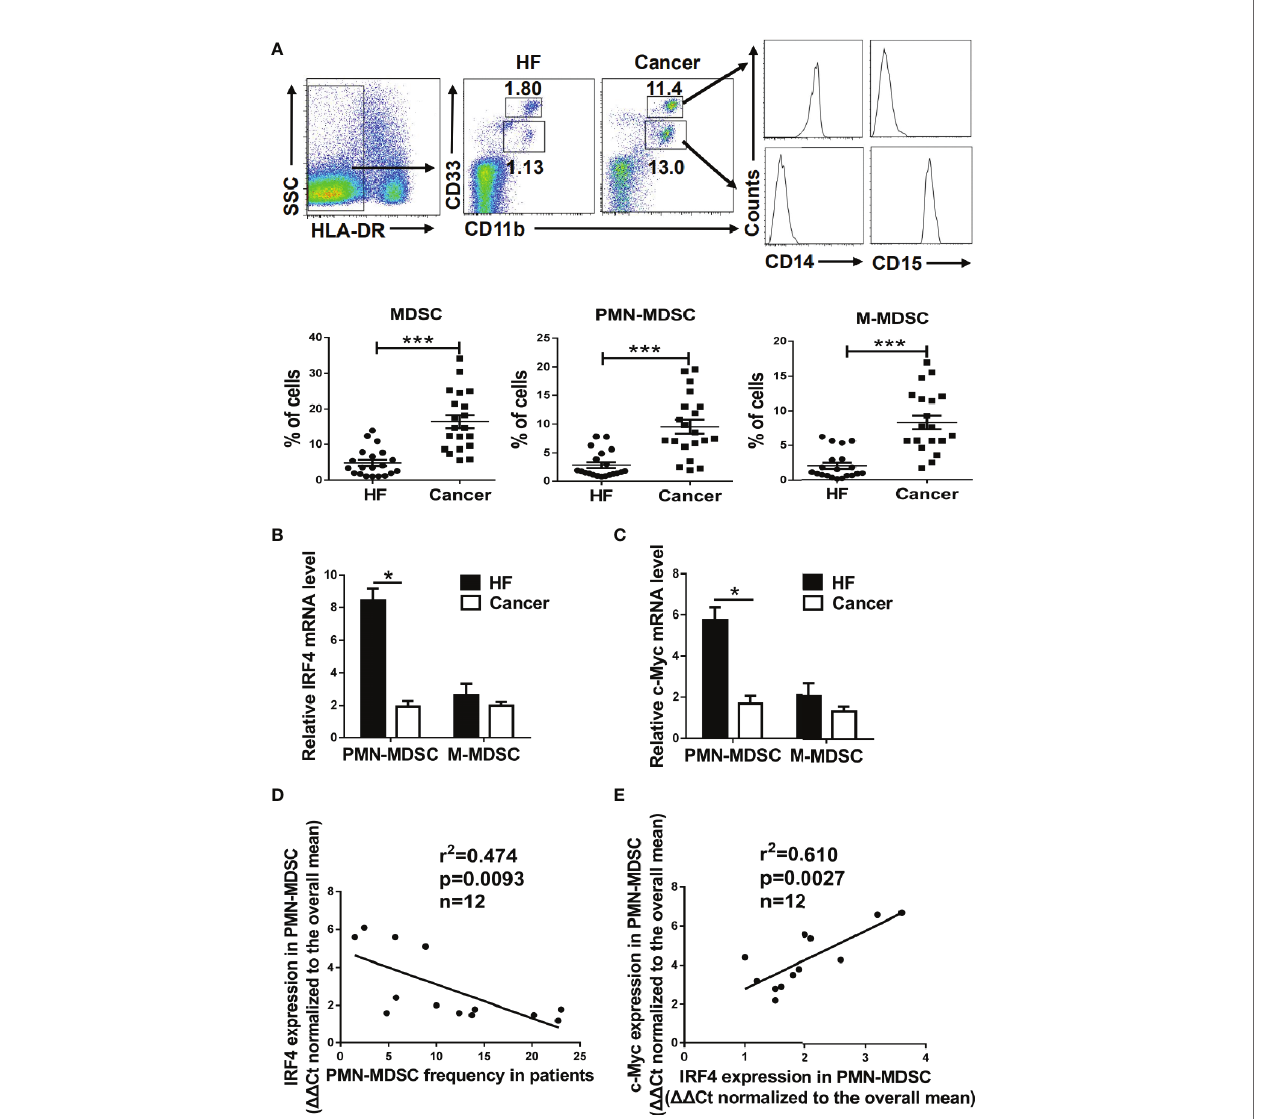
FIGURE 7 | Clinical signi fi cance of interferon regulatory factor 4 (IRF4)-mediated polymorphonuclear myeloid-derived suppressor cells (PMN-MDSCs) development. Peripheral blood samples were collected from hepatocellular carcinoma (HCC) patients (n=20); individuals with hepatic fi brosis (HF) (n=20) were used as a control. The levels of MDSCs and their subsets were determined by fl ow cytometry. (A) Representative results (upper) and mean ± SEMs (lower) are shown. (B, C) The expression of IRF4 (B) and c-Myc (C) in PMN-MDSCs and M-MDSCs were determined by qRT-PCR. Mean ± SEMs from 4 individuals are shown. (D, E) Correlations between IRF4 expression and PMN-MDSCs frequency (n=12) (D) and c-Myc expression in PMN-MDSCs (n=12) (E) are shown; Spearman rank